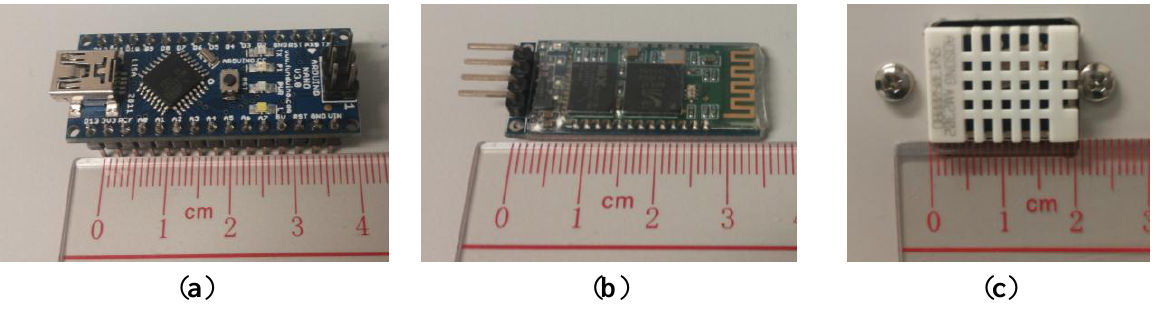
Figure 4. Calibration curve for ( a ) temperature sensor; ( b ) humidity